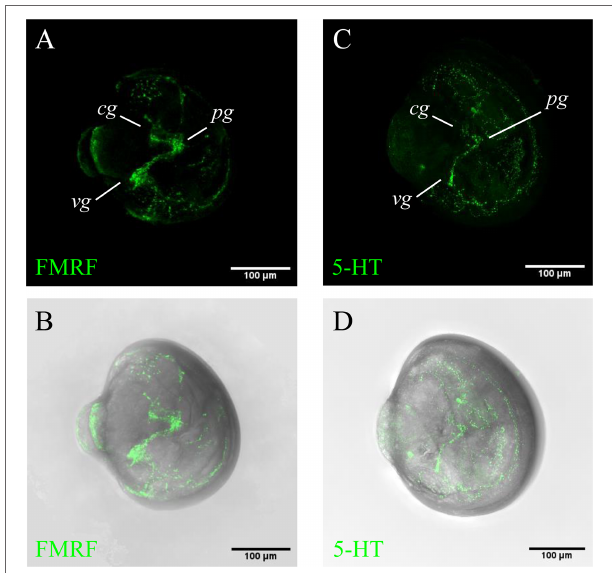
FIGURE 2 | 5-HT and FMRFamide immunoreactivity in the pediveliger larvae. The apical pole is always upward and the ventral side is on the right. (A, B) FMRFamide immunoreactive cells (green); (C, D) 5-HT immunoreactive cells (green); FMRF immunoreactive cells in the cerebral (cg), pedal (pg) and visceral (vg) ganglia and projections into interconnecting connectives and commissures. 5-HT immunoreactive cells in the region of the cerebral ganglion (cg) and their fibres innervating the pedal (pg) and visceral (vg)